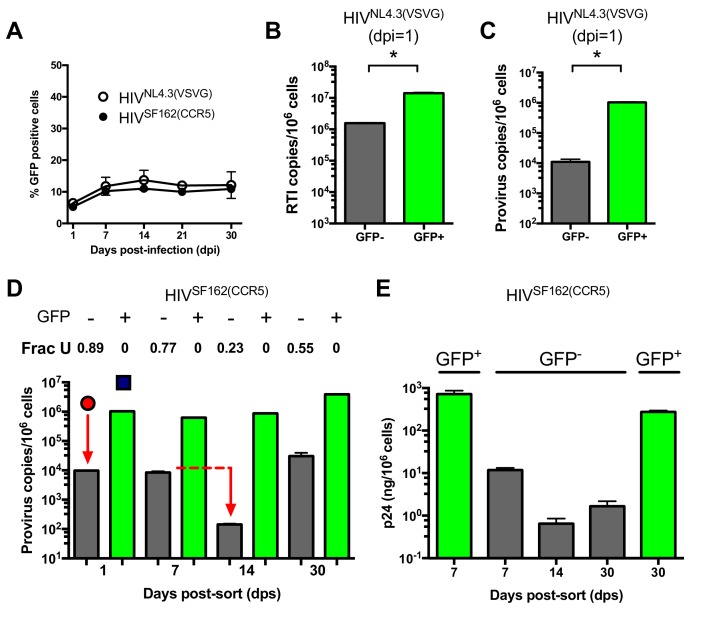
MDMs consist of two distinct cell populations with respect to viral infection.(A) Flow cytometry analysis of MDMs infected with replication-deficient HIVNL4.3(VSVG) and replication comeptent HIVSF162(CCR5) viruses. Expression of virally encoded GFP was only observed in 12–15% cells over a 30-day time-period. (B) After cell sorting according to GFP fluorescence, ddPCR was used to measure the copy number of HIVNL4.3 reverse transcription intermediates (RTIs) in GFP− (white bars) and GFP+ (green bars) MDMs. Level of statistical significance (*p<0.05). (C) ALU-gag nested qPCR measurement of the HIVNL4.3(VSVG) provirus copy number in sorted GFP− and GFP+ MDMs. (D) Measurement of HIVSF162(CCR5) provirus copy number and uracil content over the course of a 30-day multi-round infection. (E) ELISA measurements of viral p24 protein levels in GFP− and GFP+ MDMs over the course of a 30-day multi-round infection. Number of experimental replicates (n = 3–5) and errors are reported as mean ± SD.DOI:
http://dx.doi.org/10.7554/eLife.18447.00910.7554/eLife.18447.010Figure 3—source data 1.Ex-ALU-gag qPCR for measurement of reverse transcription intermediates (RTIs) and provirus content in GFP sorted MDMs (Figure 3B,C).Provirus and uracil content in GFP sorted MDMs (Figure 3D) and virus output, p24 (Figure 3E).